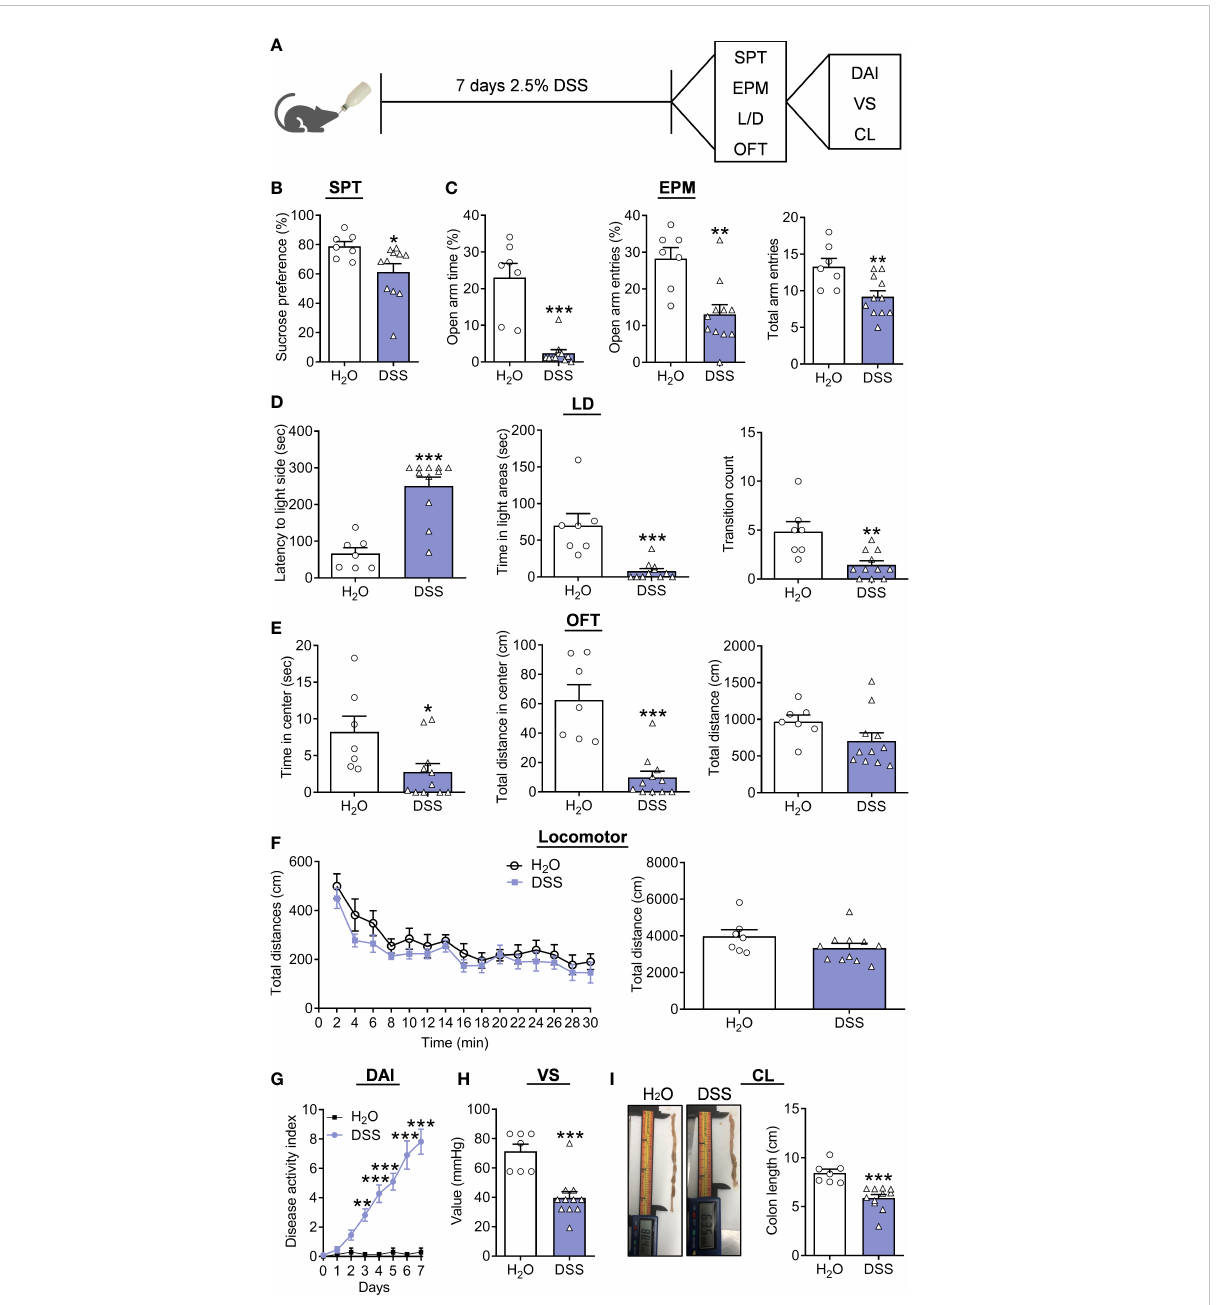
FIGURE 1 Depression/anxiety-related behaviors and colitis induced by chronic DSS (7 days) application. (A) Schematic diagram of experimental designs. (B) Sucrose preference test (SPT). (C) Elevated plus-maze test (EPM). (D) Light-dark (LD). (E) Open- fi eld test (OFT). (F) Locomotor activity. (G) Disease Activity Index (DAI). (H) Visceral sensitivity (VS). (I) Colonic length (CL). H 2 O group: n= 7, DSS group: n=11. * p < 0.05, ** p < 0.01, *** p < 0.001, compared to the control